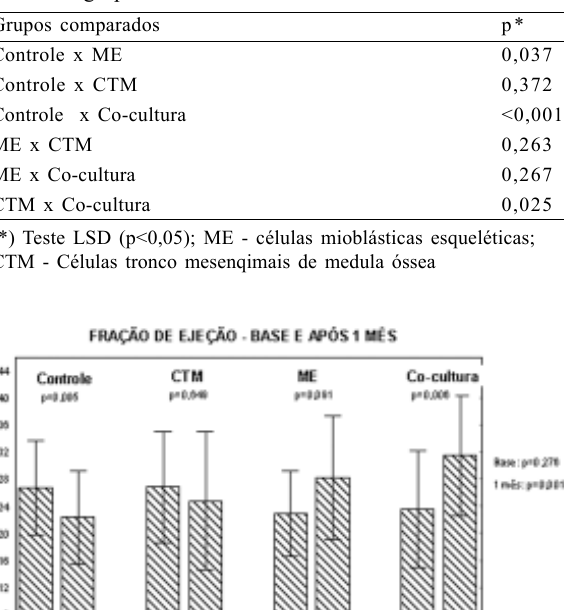
Tabela 2. Fração de ejeção após 1 mês – comparações entre